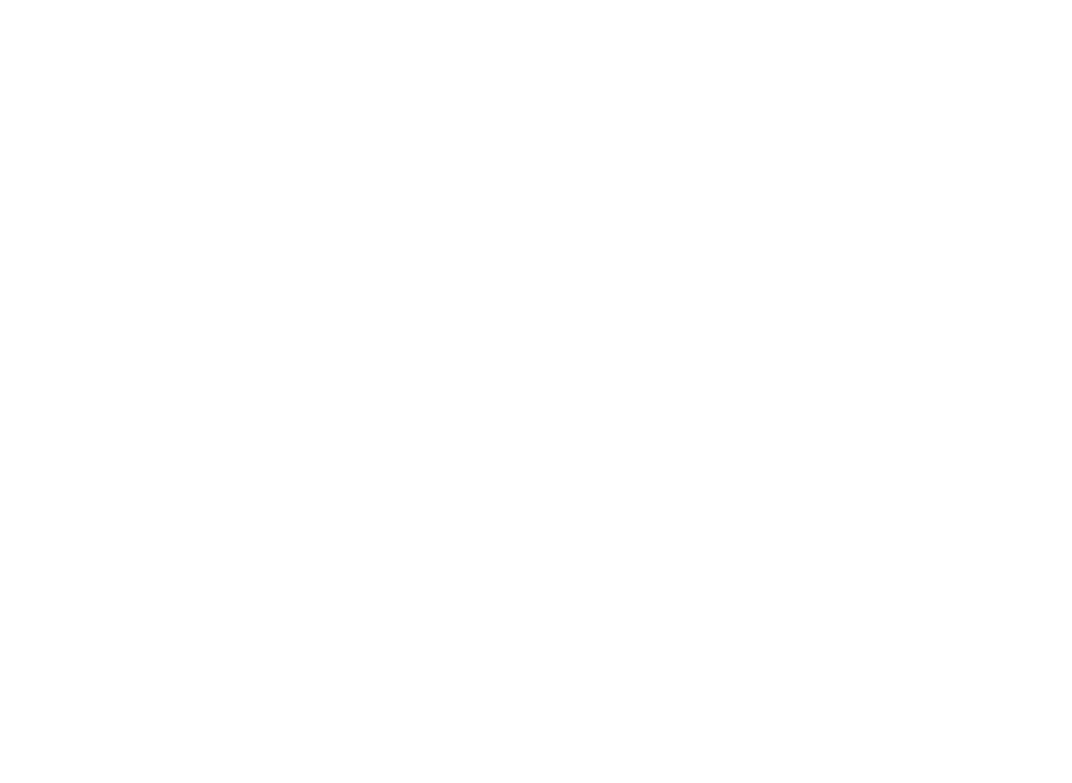
Figure 11. Images of tested surfaces of GCL showing particle-fibre interlocking ( a ) GCL-River sand ( b ) GCL-